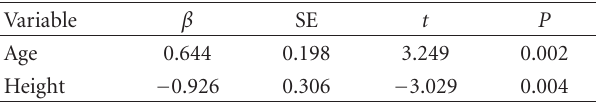
Table 7: Stepwise regression analysis for AI (nondiabetic patients). R 2 = 0 . 428, RMSE 16.52, F = 18 . 33, P < . 001.